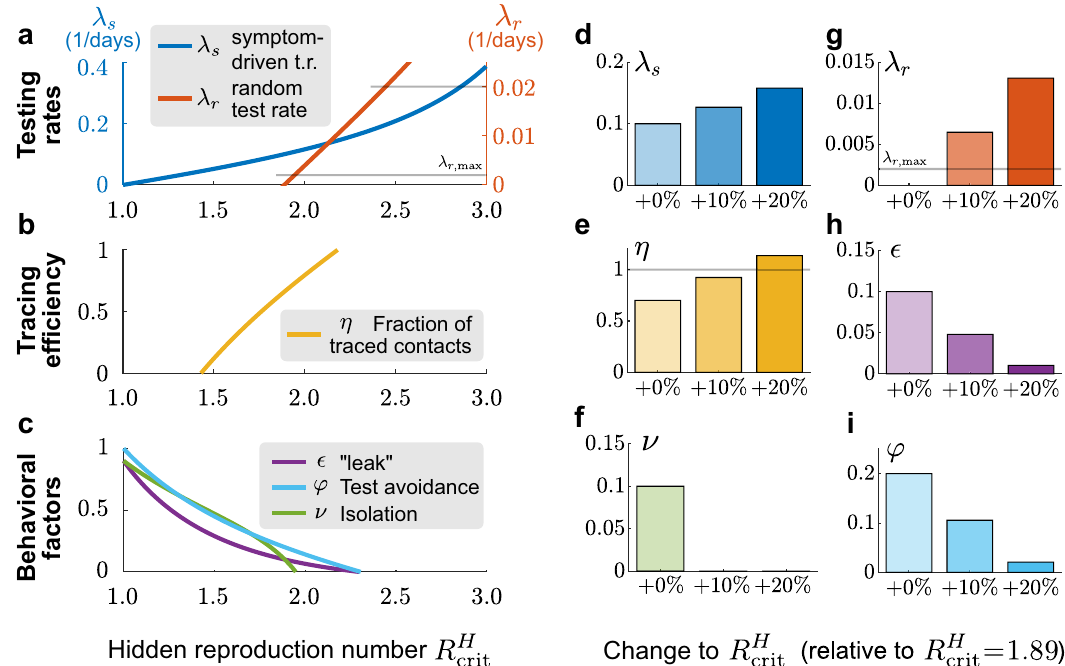
Fig. 8 Adapting testing strategies allows the relaxation of contact constraints to some degree. The relaxation of contact constraints increases the reproduction number of the hidden pool R H t , and thus needs to be compensated by adjusting model parameters to keep the system stable. a – c Value of a single parameter required to keep the system stable despite a change in the hidden reproduction number, while keeping all other parameters at default values. a Increasing the rate of symptom-driven testing ( λ s , blue) can in principle compensate for hidden reproduction numbers close to R 0 . However, this is optimistic as it requires that anyone with symptoms compatible with COVID-19 gets tested and isolated on average within 2.5 days — requiring extensive resources and ef fi cient organization. Increasing the random-testing rate ( λ r , red) to the capacity limit (for the example Germany, gray line λ r ; max ) would have almost no effect, pooling tests to achieve 10 λ r ; max can compensate partly for larger increases in R H t . b Increasing the tracing ef fi ciency ( η ) can compensate only small increases in R H t . c Decreasing the fraction of symptomatic individuals who avoid testing ( φ ), the leak from the traced pool ( ϵ ) or the escape rate from isolation ( ν ) can in principle compensate for small increases in R H t . d – i To compensate a 10% or 20% increase of R H t , while still keeping the system stable, symptom-driven testing ( λ s ) could be increased ( d ), or ϵ or φ could be decreased ( h , i ). In contrast, only changing λ r , η , or ν would not be suf fi cient to compensate a 10 % or 20 % increase in R H t , because the respective limits are reached ( e , f , g ). All parameter changes are computed through stability analysis (Supplementary Eq.